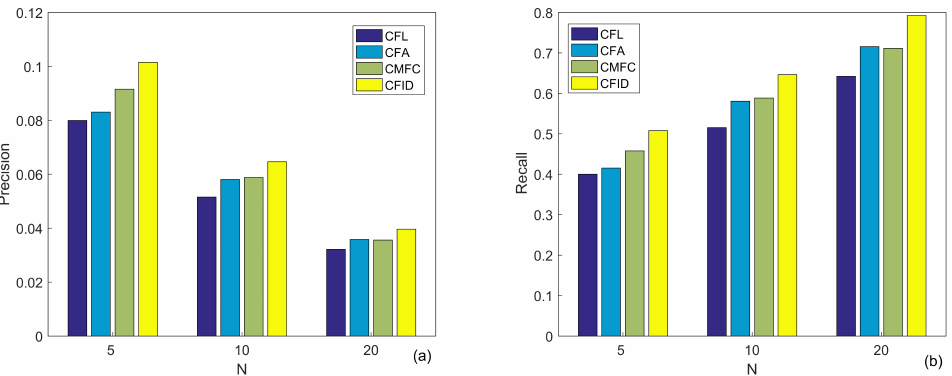
Figure 8. Multi-person group recommendation results of four algorithms on Tokyo dataset. ( a ) preci- sion result; ( b ) recall